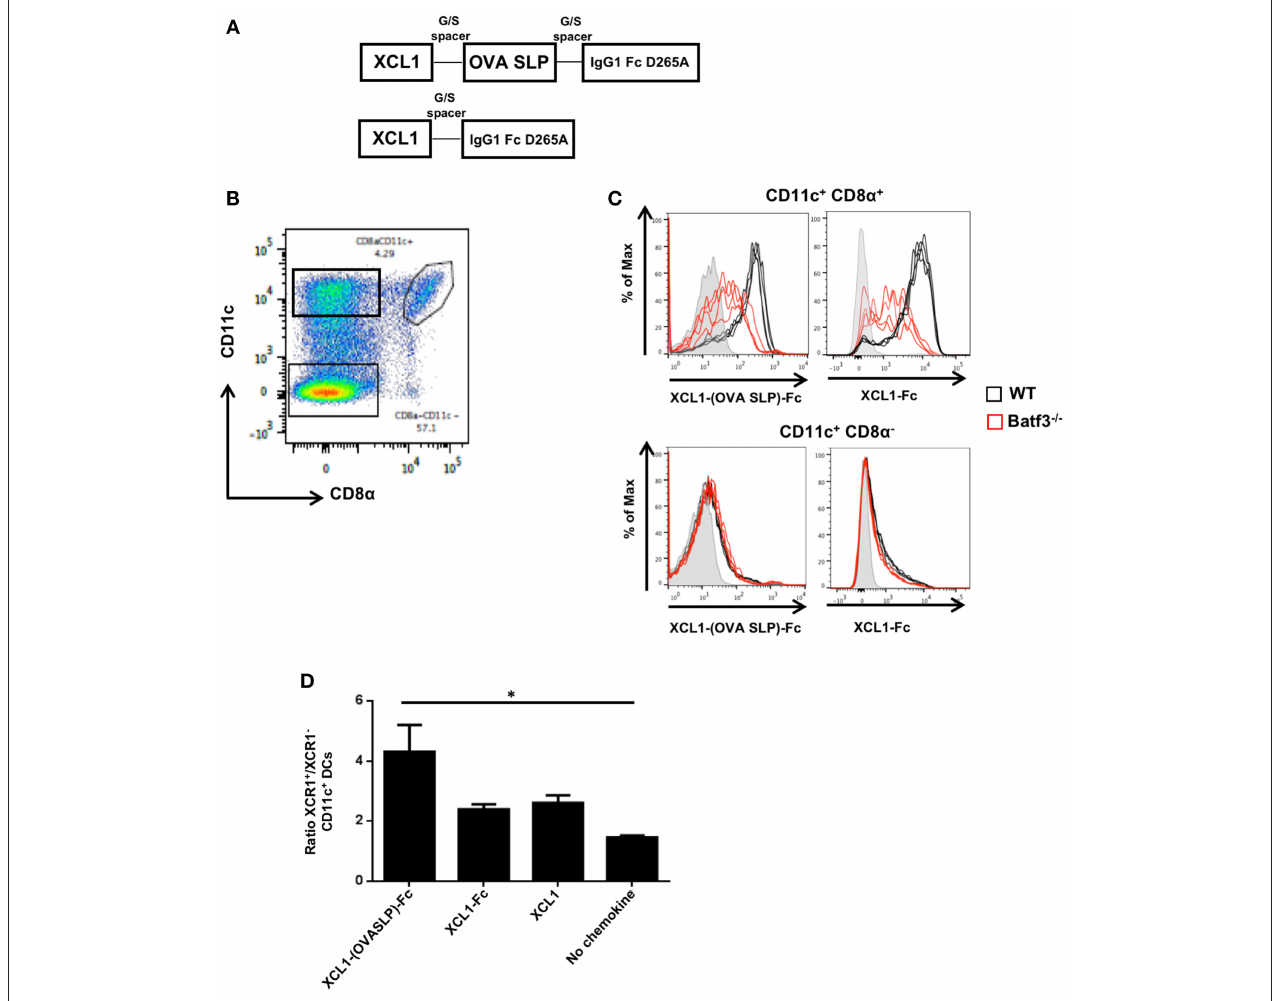
FIGURE 1 | In vitro characterization of Xcl1-(OVA SLP)-Fc fusion proteins. (A) Design of Xcl1-(OVA SLP)-Fc fusion proteins. The OVA SLP was fused to the C-terminus of the murine Xcl1 amino acid sequence via an uncharged glycine/serine linker. The C-terminus of OVA SLP was connected to the murine IgG1 Fc, carrying the D265A mutation. (B) Gating strategy to identify CD8 α DCs. (C) CD11c-enriched DCs from splenocytes of naive WT (C57BL/6) (black line) or Batf3 − / − (red line) mice were incubated with purified Xcl1-(OVA SLP)-Fc or Xcl1-Fc fusion proteins. Binding of XCL1 fusion proteins was assessed using a fluorescent anti-mouse IgG1 antibody. Gray histograms represent control wells without fusion proteins. Each line represents a replicate. Results are representative of two independent experiments. (D) In vitro chemotaxis assay performed with WT splenic DCs (enriched ∼ 50% CD11c + ). Migration of DCs was assessed toward Xcl1-(OVA SLP)-Fc fusion proteins at 25nM (calculated based on the content of Xcl1 in the reagents). Results are expressed as the ratio between the number of Xcr1 + and Xcr1 − CD11c + CD11b − DCs, which migrated toward Xcl1 fusion proteins or commercial Xcl1. Data are shown as mean ± SEM. Results are representative of three independent experiments. * p <